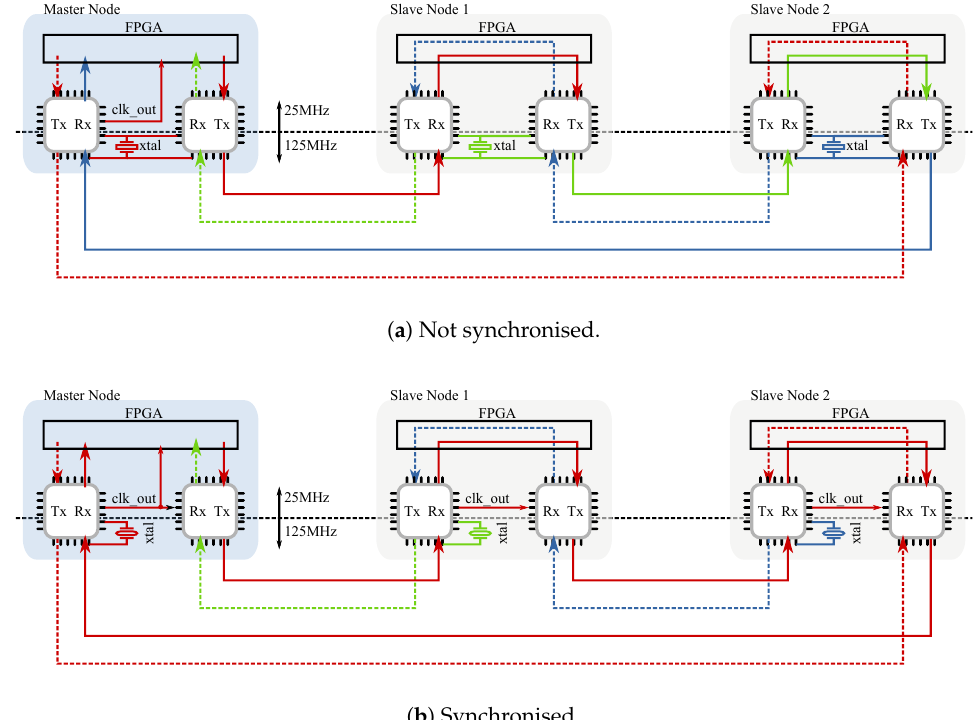
Figure 7. Physical Layers synchronisation. The continuous lines represent one direction of the ring network and the dashed lines the other